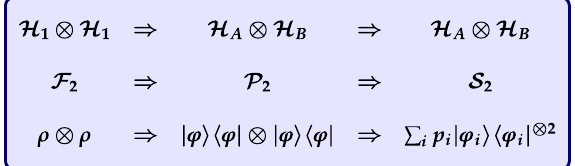
FIG. 5. An illustration of the relations between the two-party feasible region F 2 , the two-party purification P 2 , and the two- party extension S 2